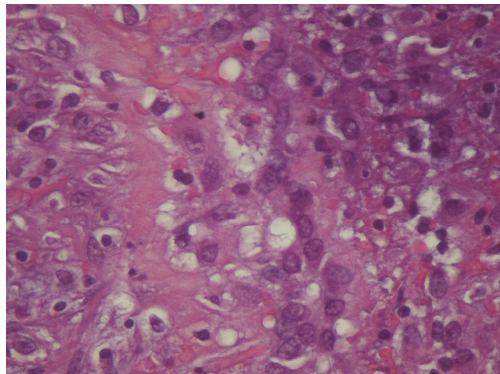
Figure 1: Histological section of the cystic wall showing the presence of mesothelial cells (Hematoxylin-Eosix × 400).